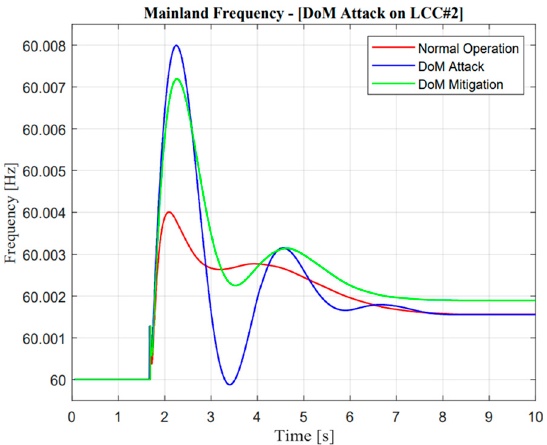
Figure 21. Mainland frequency in the delay of measurement attack operation.